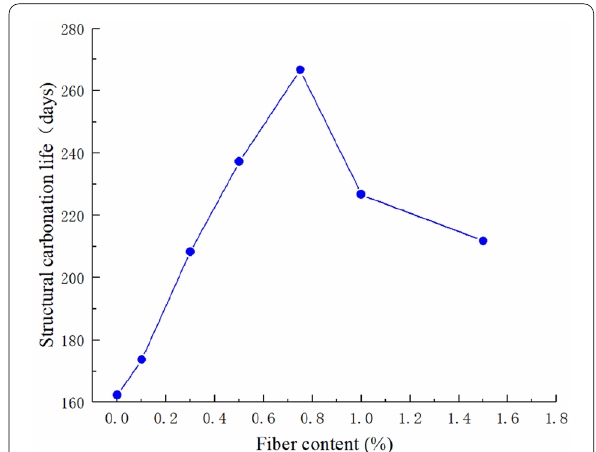
Fig. 12 Carbonation life versus fiber content for the 6 mm length PVA fiber concrete component under the accelerated carbonation experiment